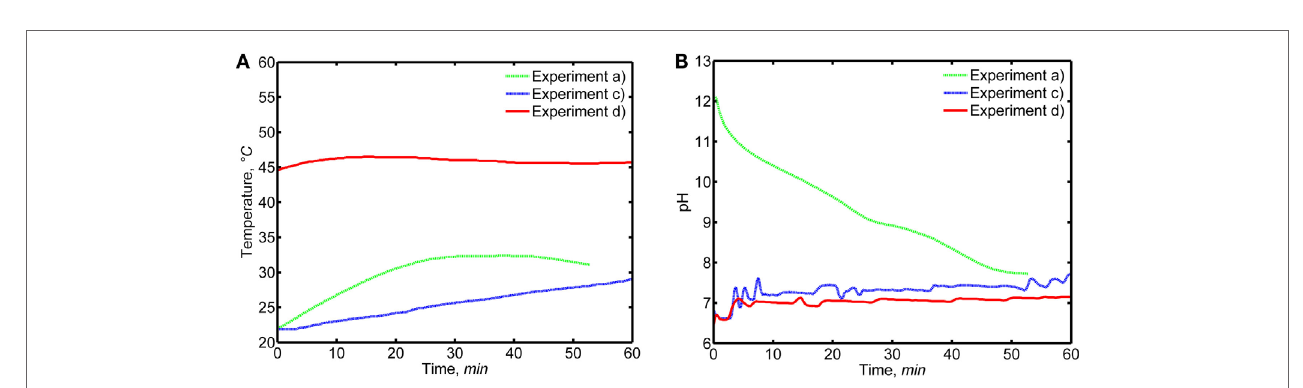
FigUre 3 | (a) Temperature and (B) pH during the first 60 min of experiments (a), (c), and (d).